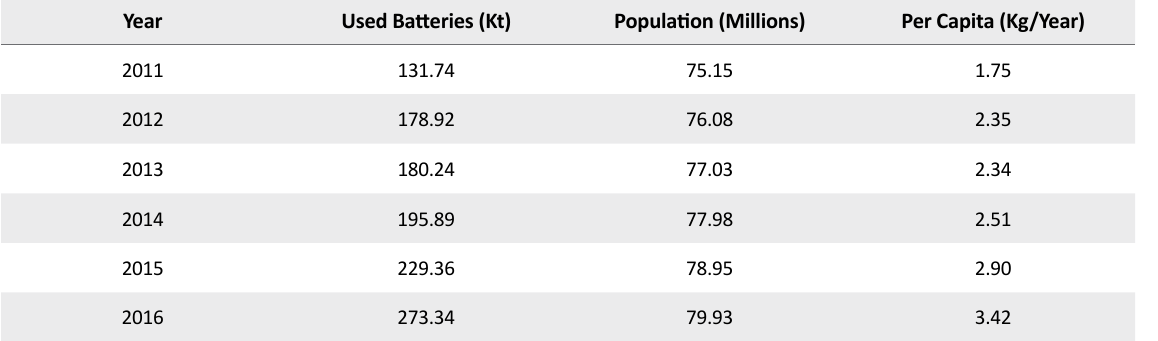
Table 3. Used batteries and per capita use between 2011 and 2016